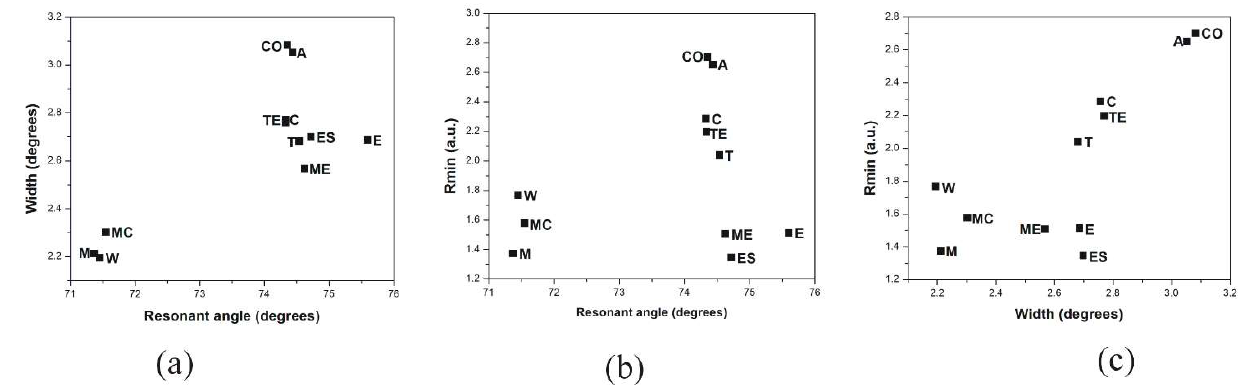
Figure 3. Multiparameter analysis of SPR parameters extracted from mezcal curves. ( a ) Plot of width vs. resonant angle, ( b ) R min vs. resonant angle, and ( c ) R min vs. width. The samples nomenclature corresponds to the mezcal samples: espadín (ES), tobalá (T), cuishe (C), tepeztate (TE), mexicano (ME), arroqueño (A), madre chuishe (MC), and coyote (CO), and the reference solutions: distilled water (W), methanol (M), and ethanol (E).